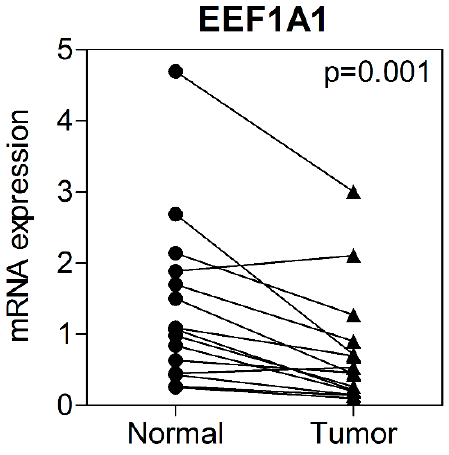
Figure 2. Expression of EEF1A1 in colon cancer tissue and normal adjacent tissue.